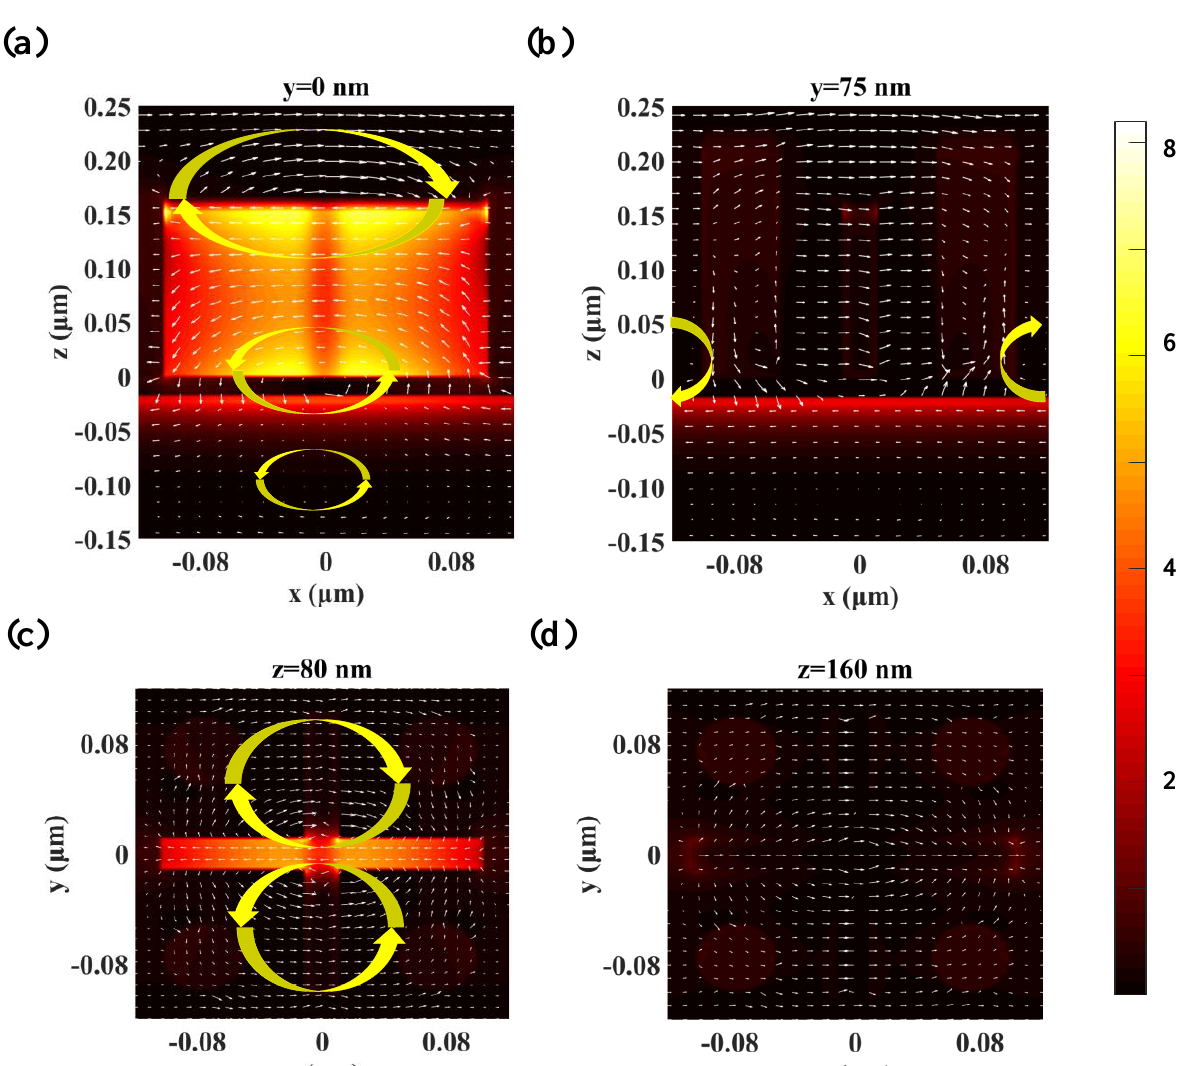
Figure 4. Current vector distributions of the absorber at the wavelength of 2160 nm. ( a , b ) The current vector distribution in the x – z plane at y = 0 and 75 nm, respectively. ( c , d ) The current vector distribution in the x – y plane at z = 80 and 160 nm, respectively.